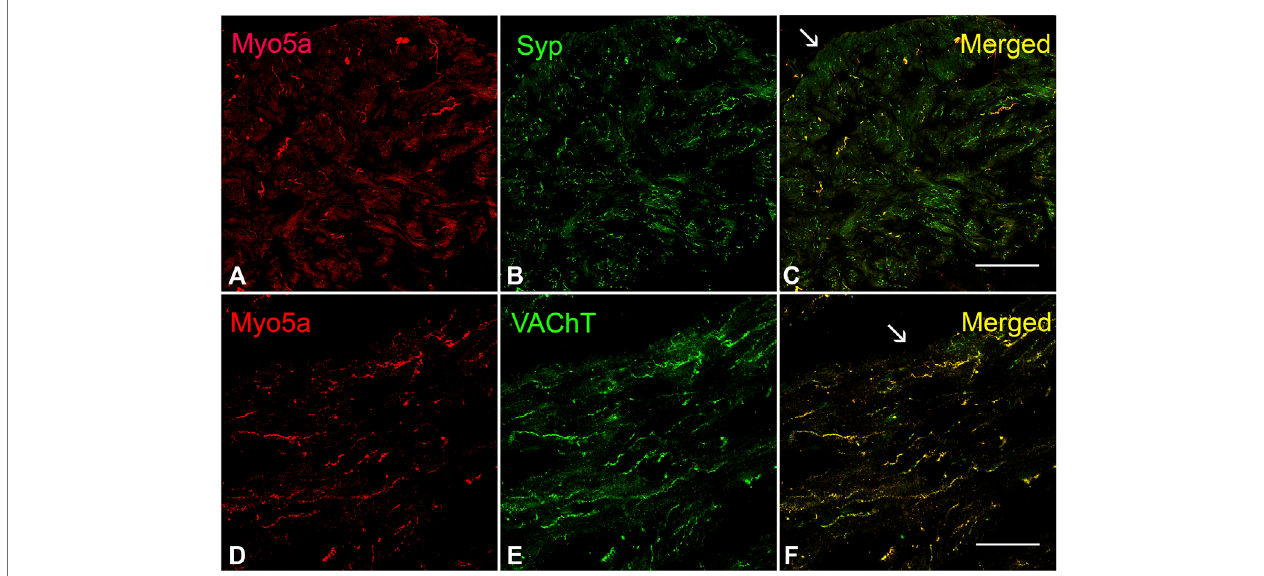
FIGURE 1 | Expression of Myo5a in bladder tissue. (A – C) Laser scanning confocal microscopy of sections from WT detrusor detected Myo5a immunoreactivity (red staining) on nerve fi bers that were immunoreactive for the pan-neuronal marker synaptophysin (Syp, green staining). The merged image on the right shows co- localization of these markers in yellow. (D – F) Immunoreactivity for Myo5a (red staining) and vesicular acetylcholine transporter (VAChT, green staining) in WT bladder muscularis . Co-localization of these two proteins in the merged panel (yellow) indicates expression of Myo5a in cholinergic fi bers of the urinary bladder. Arrows indicate serosa. (Scale bar = 50 µm; Mag